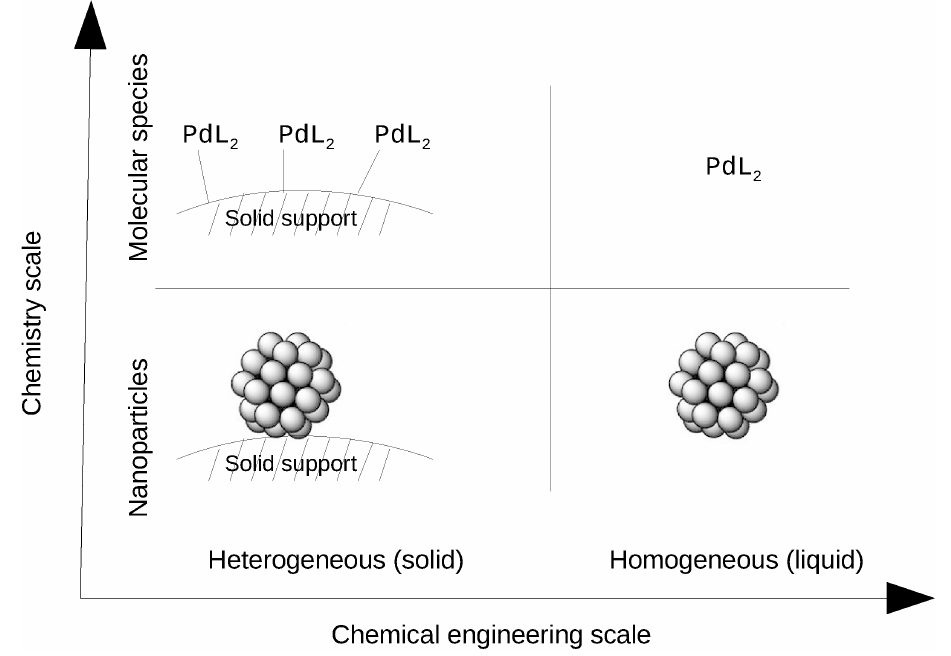
Figure 2. Definition of homogeneous and heterogenous systems in this